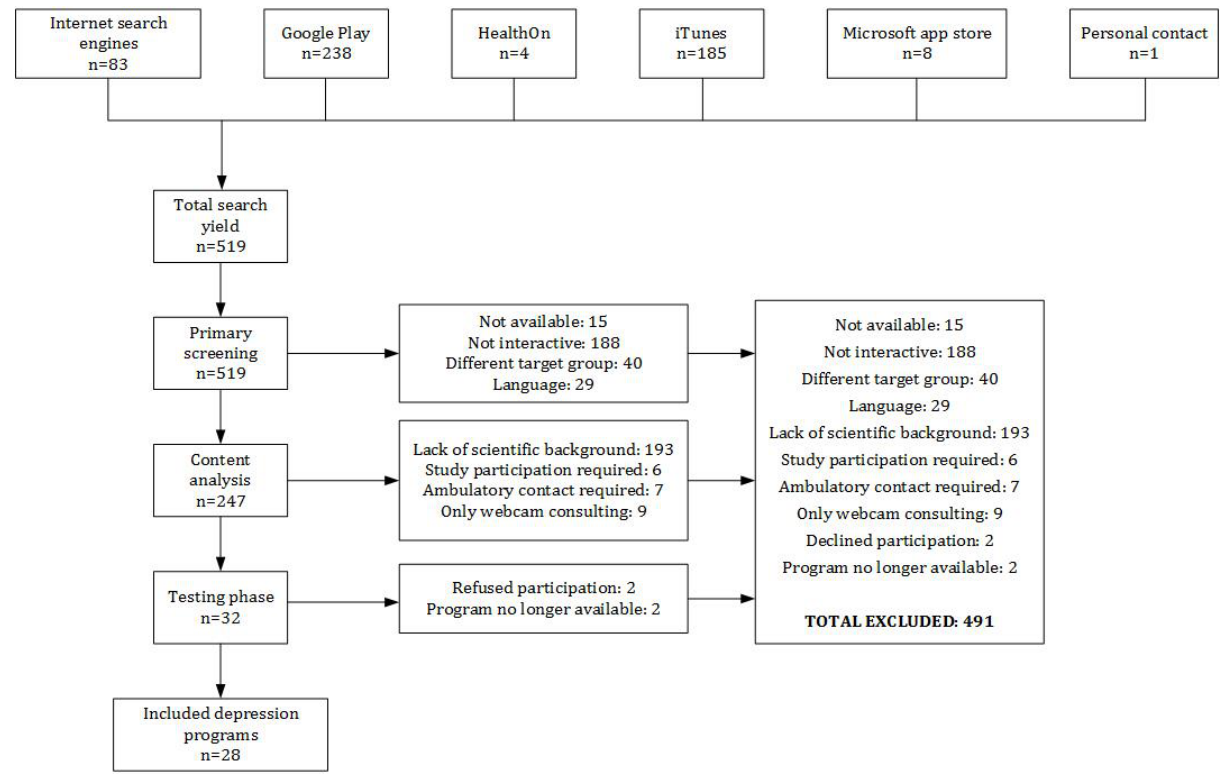
Figure 1. Flowchart of the screening process to identify desktop programs and